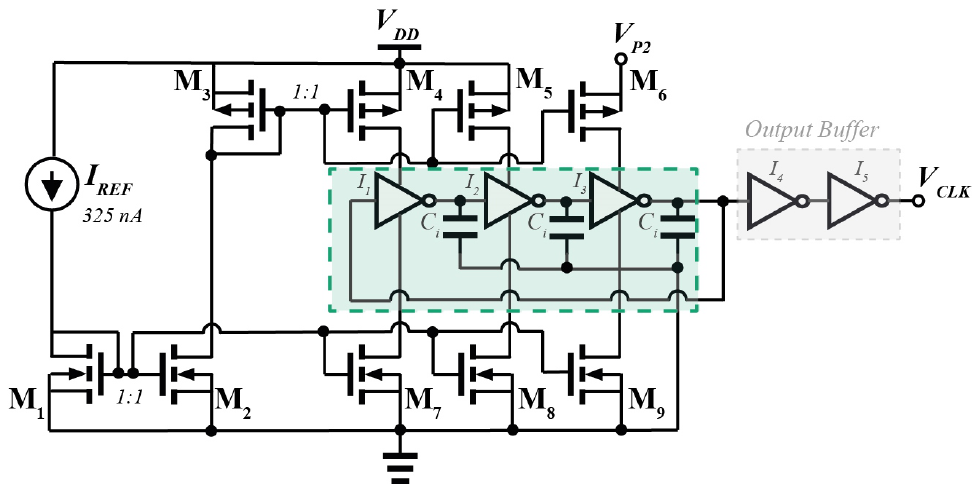
Figure 10. Schematic of the proposed current starved gated ring oscillator